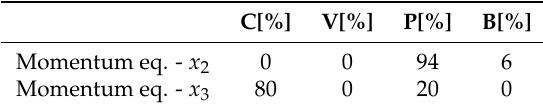
Table A1. Terms decomposition of the momentum